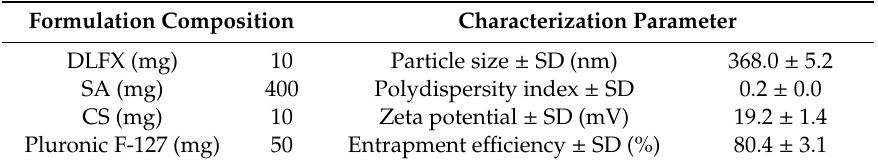
Table 1. The composition and characterization data of DLFX-loaded SA-CS-SLNs ( n =